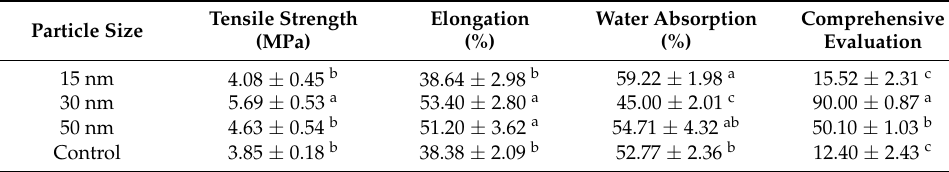
Table 1. Effects of particle size of nano-TiO 2 on the properties of the